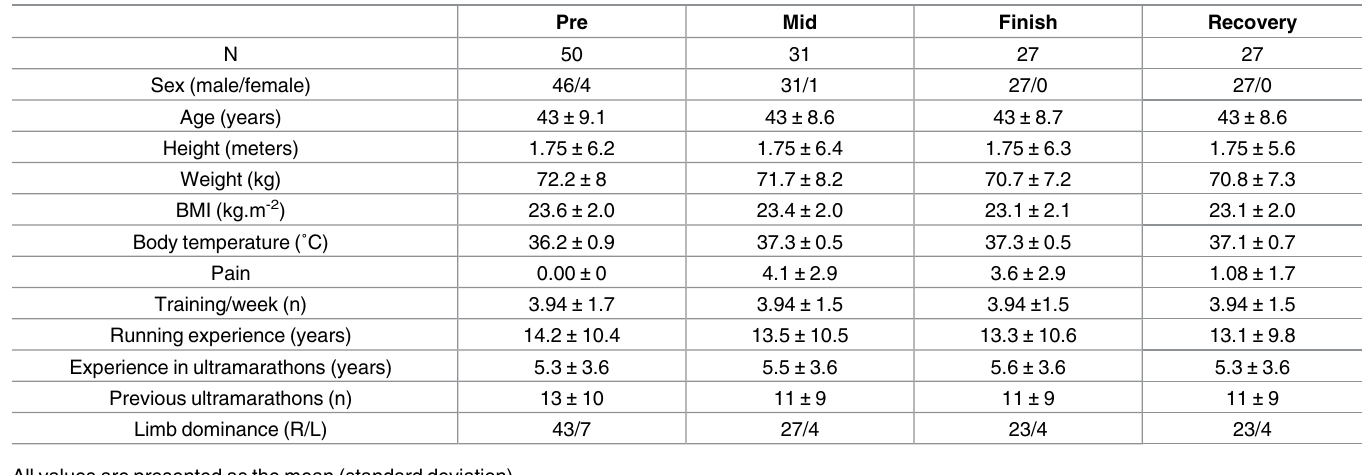
Table 1. Demographic and training profile